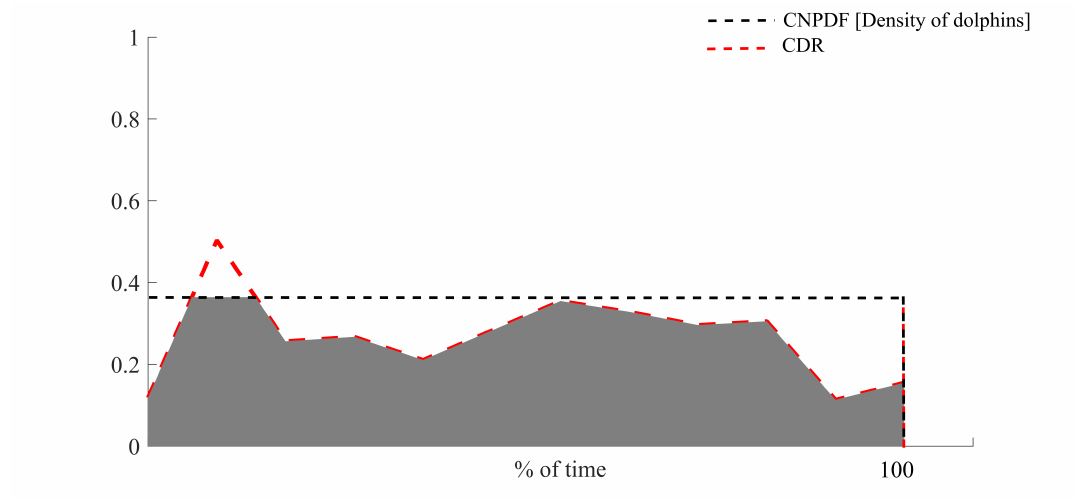
Figure 8. Example of the coincident area between the intersection of the evolution curves of the variables CNPDF (black dashed line) and CDR (red dashed line) during the evaluation period in a specific map cell. Both variables defined between [0–1] are represented in the y -axis during the assessment period in percentage of time ( x